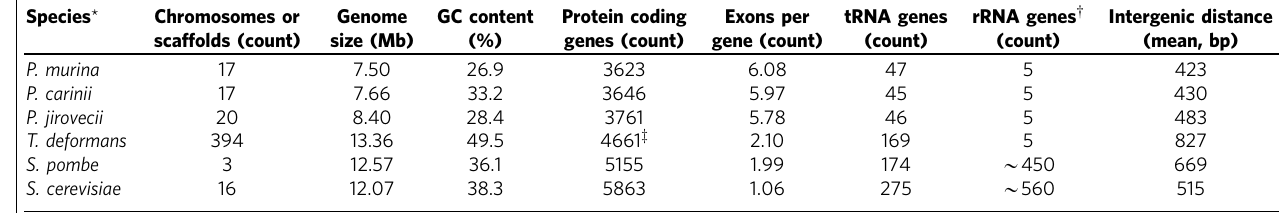
rRNA, ribosomal RNA; tRNA, transfer RNA *Genome data sources are provided in Supplementary Table 2. w Supplementary Note